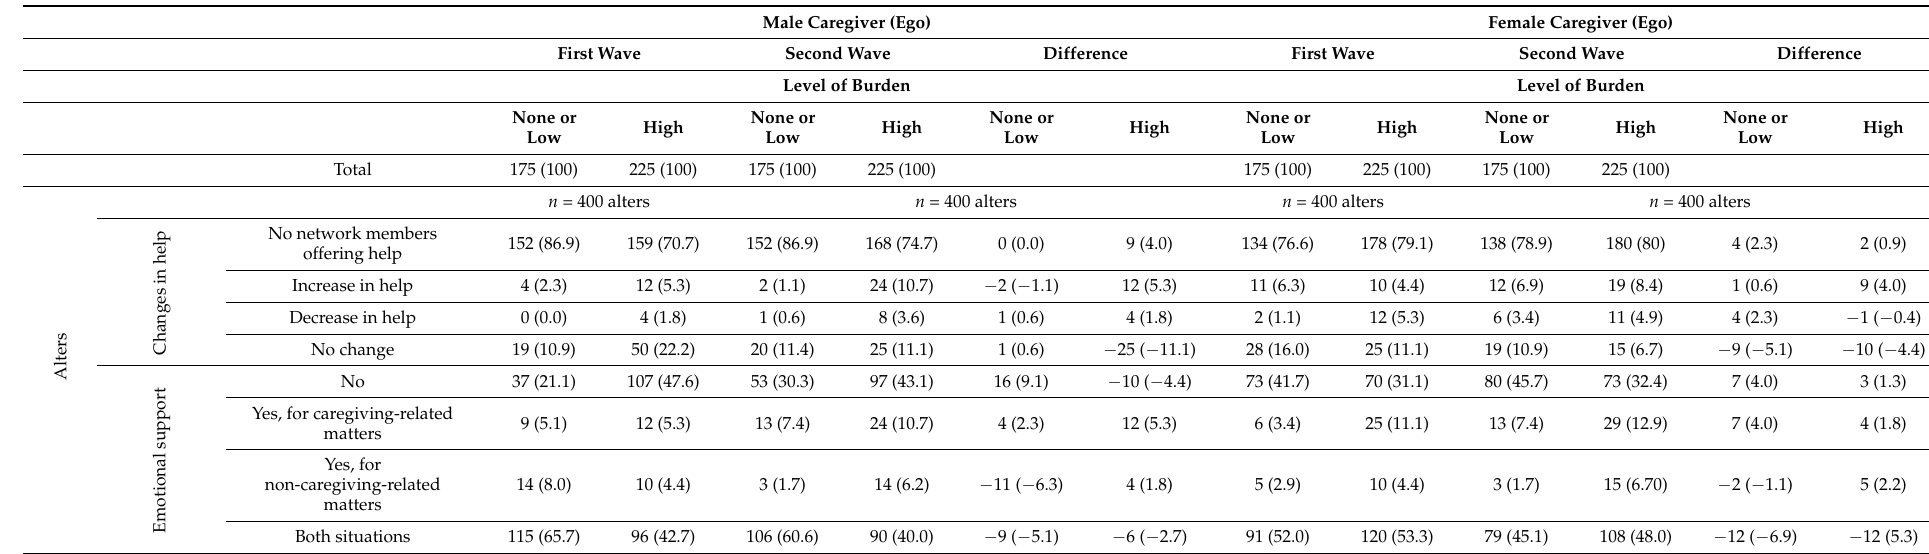
Table 3. Changes in network support according to caregiver gender and